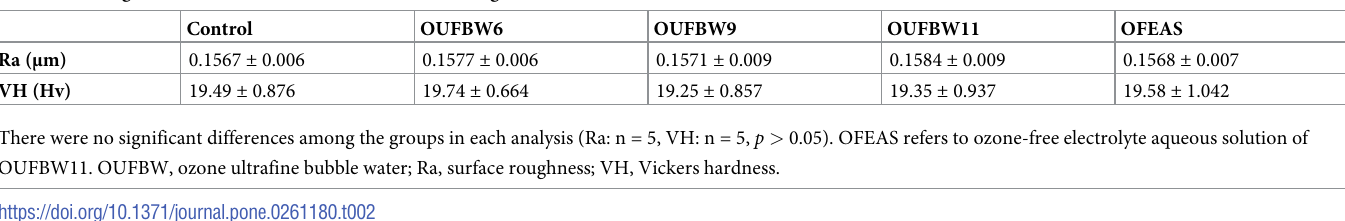
Table 2. Average ± standard deviation values of surface roughness and Vickers